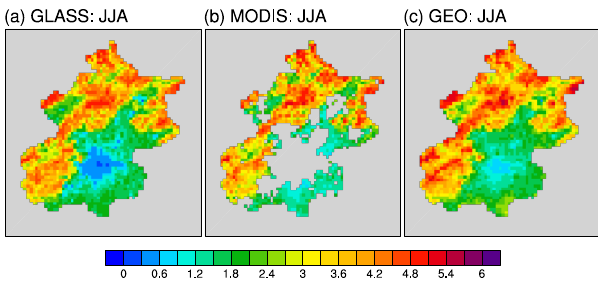
Figure 4. The average spatial distribution of (a) GLASS, (b) MODIS and (c) GEO v2 LAI in summer (June, July and Au- gust; JJA).